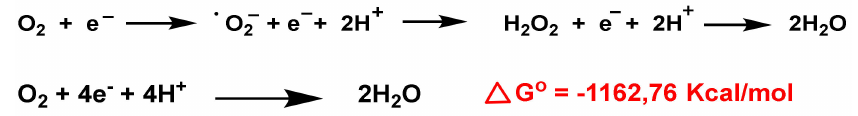
Figure 3. O 2 reduction chain to • O 2 − , H 2 O 2 and H 2